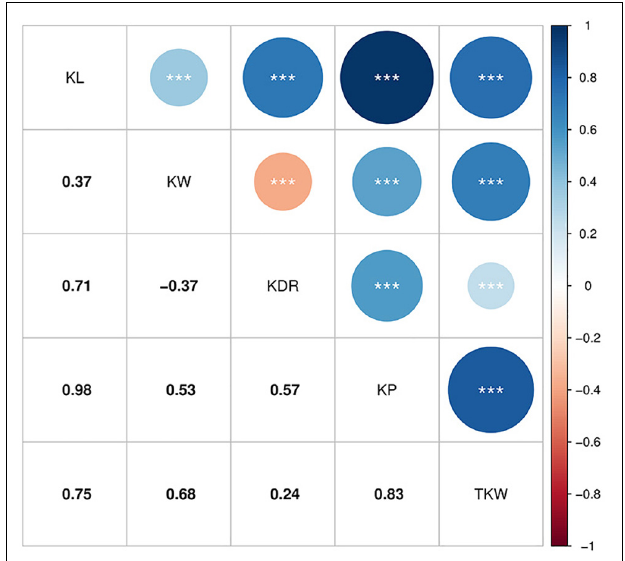
FIGURE 2 | Pearson’s correlation coefficients among BLUP for the kernel traits. ***Significant at P < 0.001.